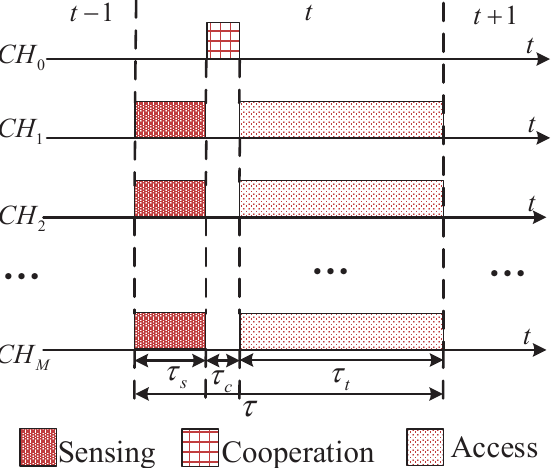
Figure 3. Structure of one time slot for the joint channel sensing and access